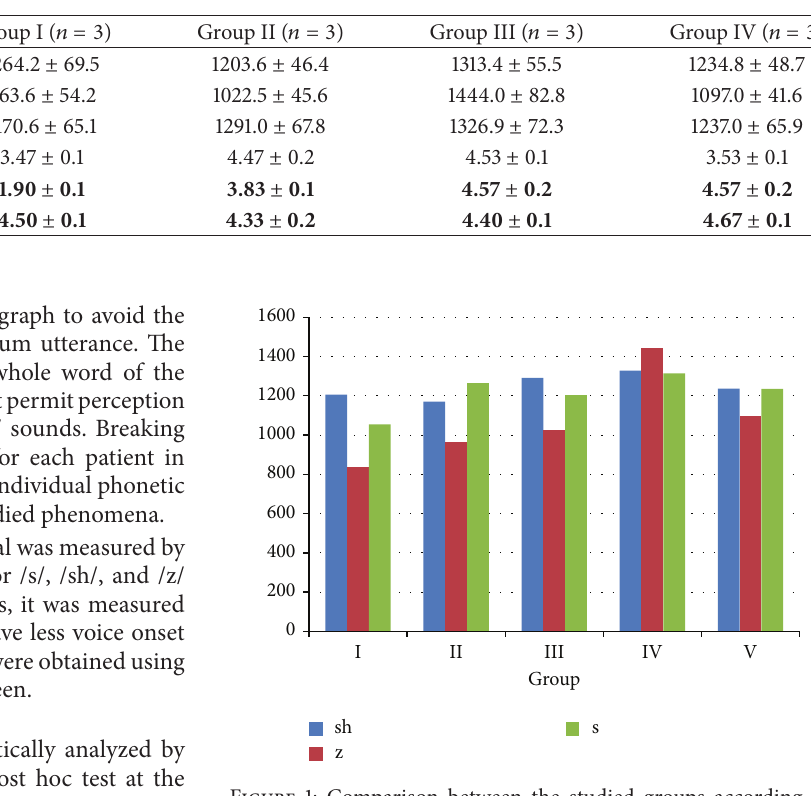
Figure 1: Comparison between the studied groups according to /sh/z/t/ sounds measured by the maximum energy (frequency, HZ).